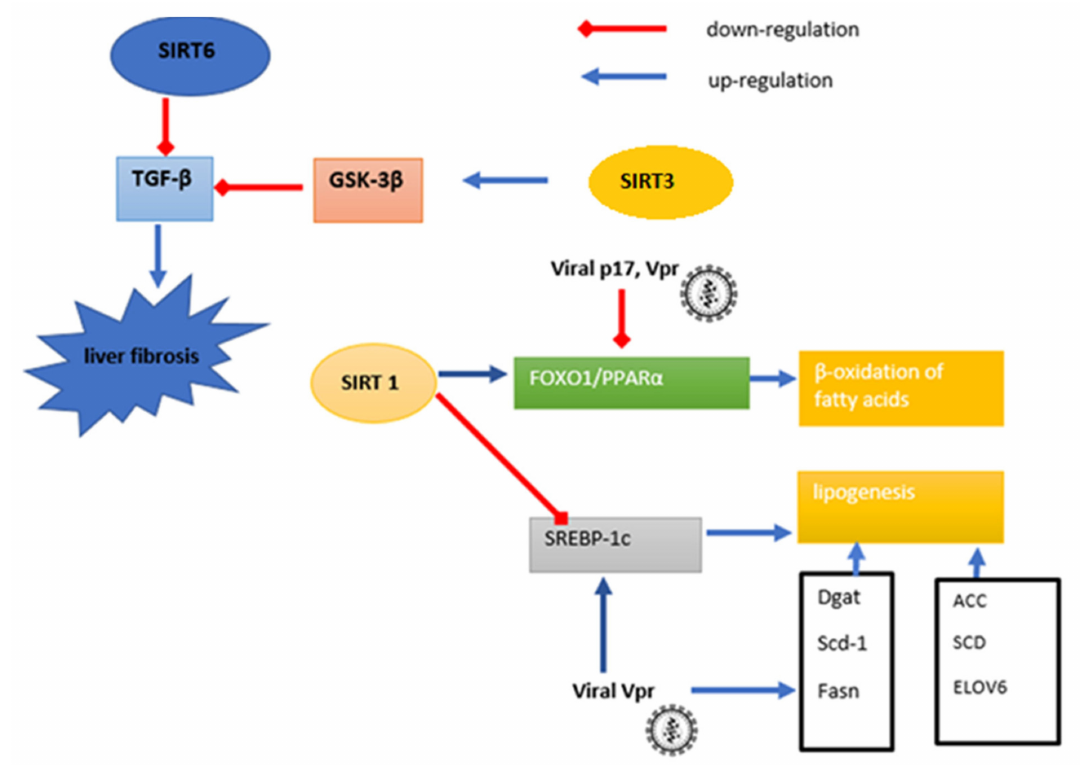
Figure 2. Scheme of connection between sirtuins, HIV and hepatic metabolism. SIRT3 deacetylates GSK-3 β , increasing its activity, which in turn weakens TGF- β signaling. SIRT6, through down-regulation of TGF- β signaling reduces the expression of profibrogenic genes. SIRT1 up-regulates fatty acid oxidation in hepatocytes via the FOXO1/PPAR α signaling pathway. Viral protein Vpr acts opposite to SIRT1 to increase expression of genes responsible for the synthesis of fatty acids by increasing SREBP1c activity. SREBP-1c, sterol regulatory element binding protein-1c; FOXO1, forkhead box protein O1; PPAR α , peroxisome proliferator-activated receptor α ; TGF β , transforming growth factor β ; GSK-3 β , glycogen synthase kinase 3